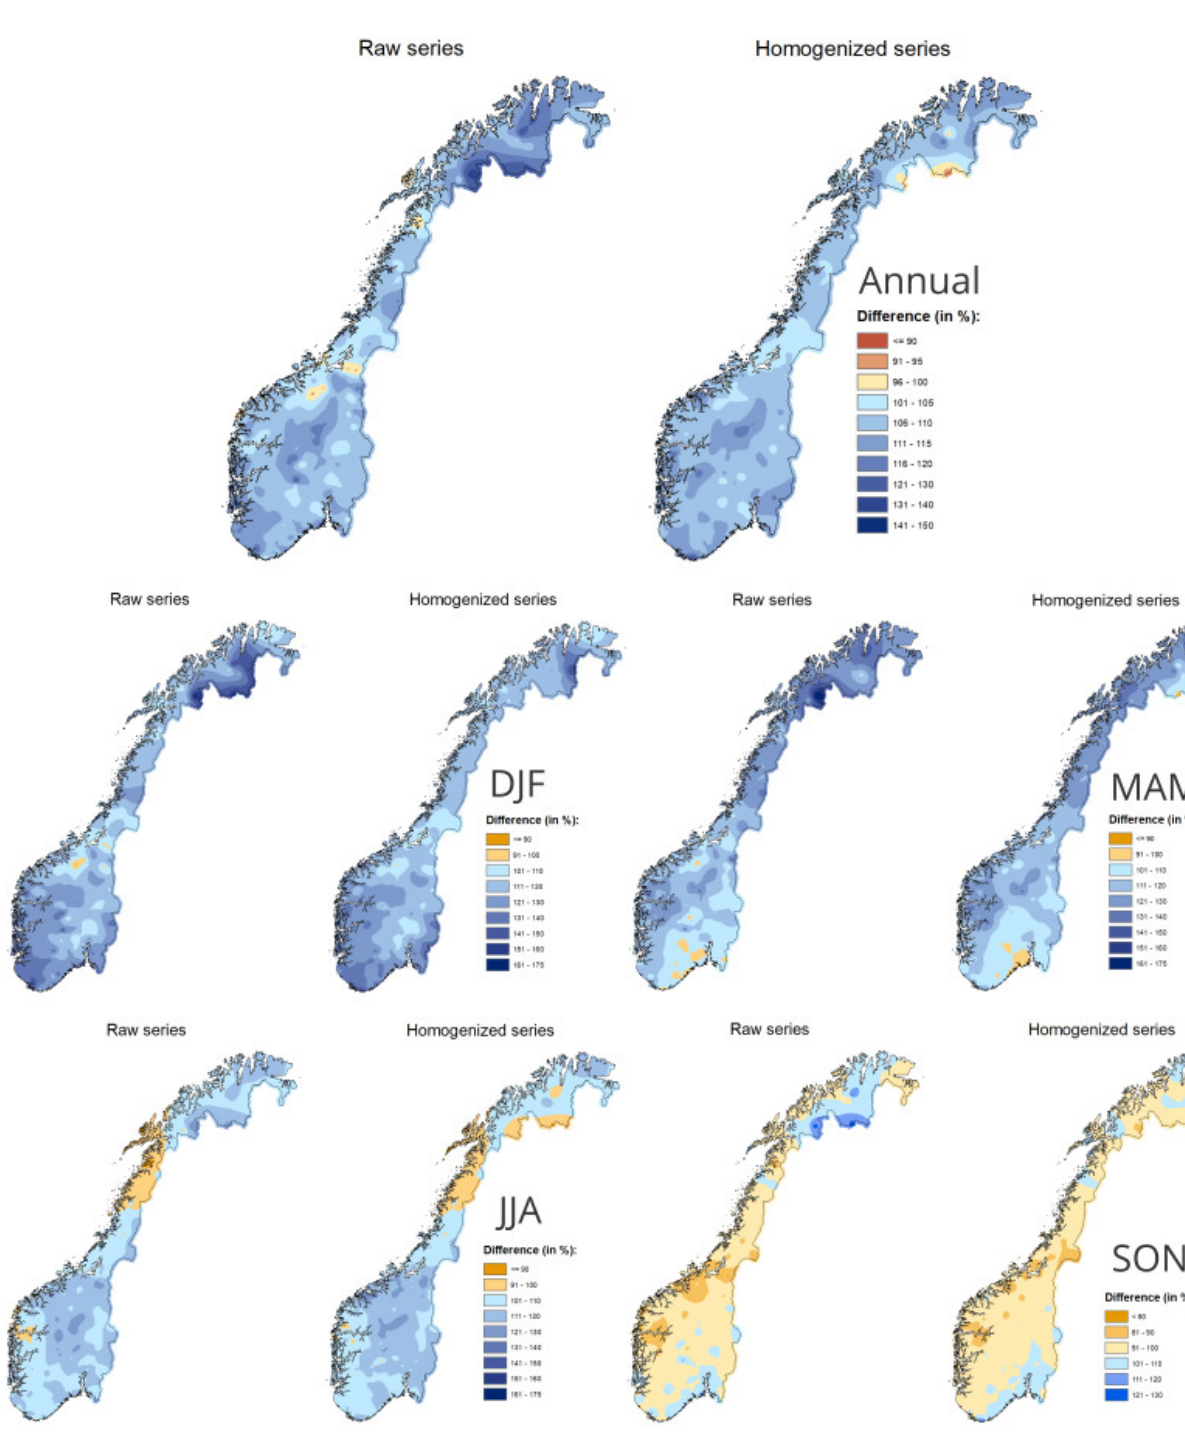
Adv. Sci. Res., 19, 73–80,